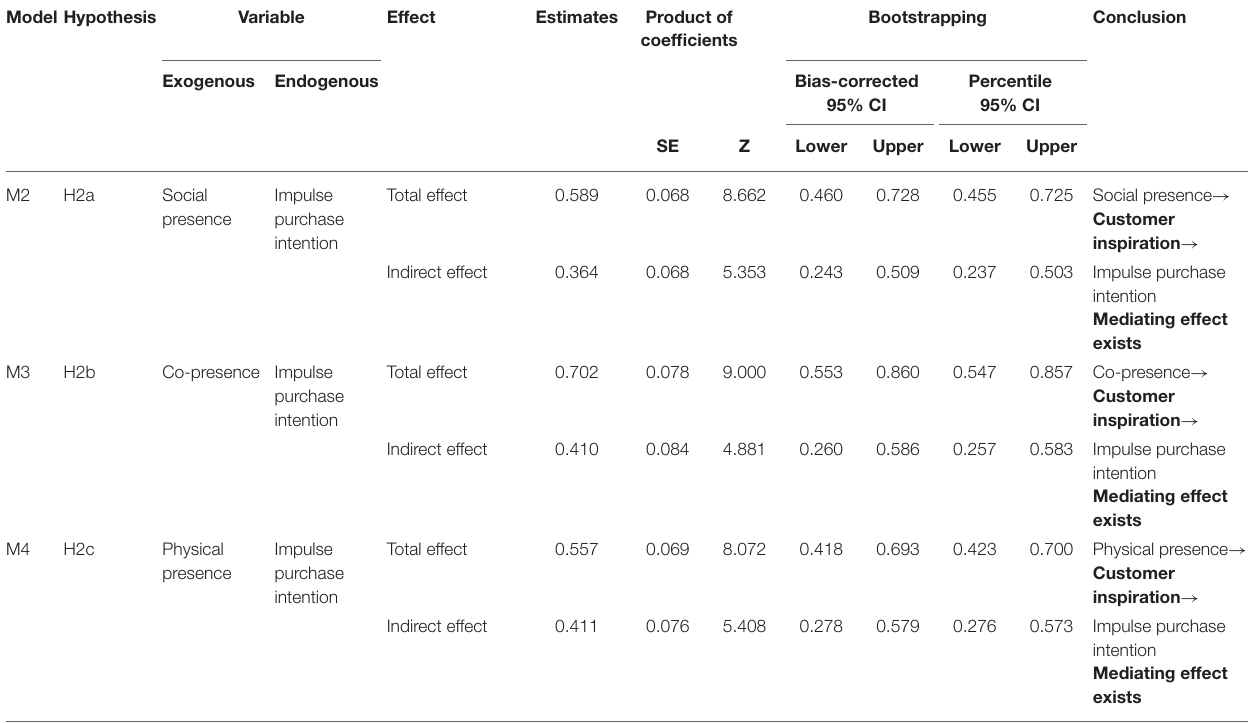
TABLE 8 | Results of mediating